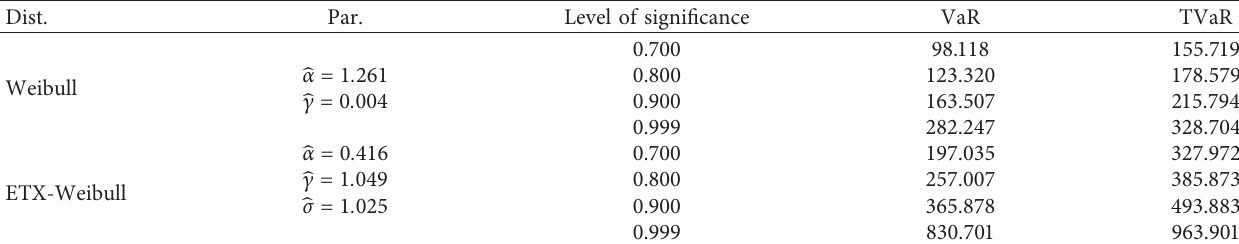
Table 5: The estimated values of the parameters with standard errors (in parenthesis) of the fitted distributions. Dist.